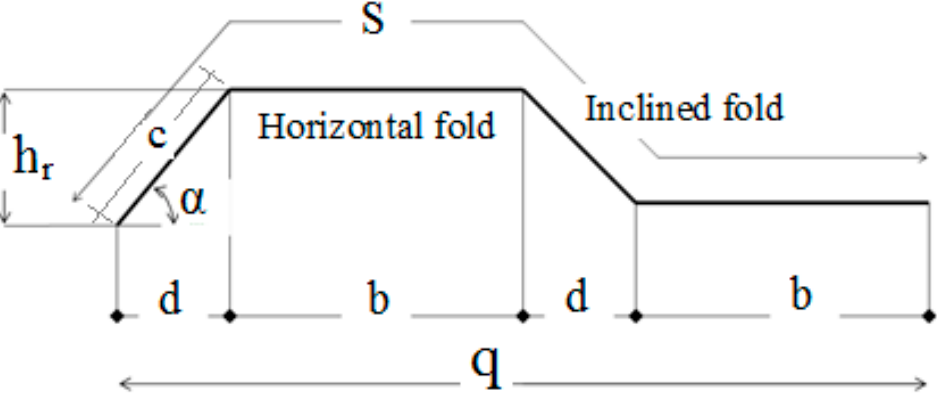
Figure 1. Corrugated web: profile configuration.